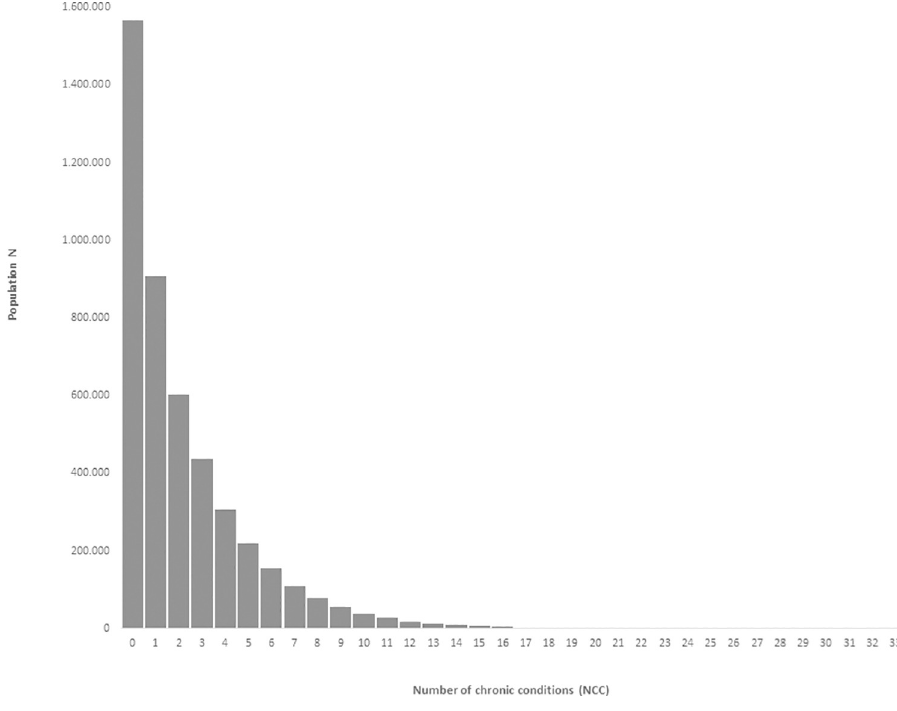
Fig 1. NCC in the Danish